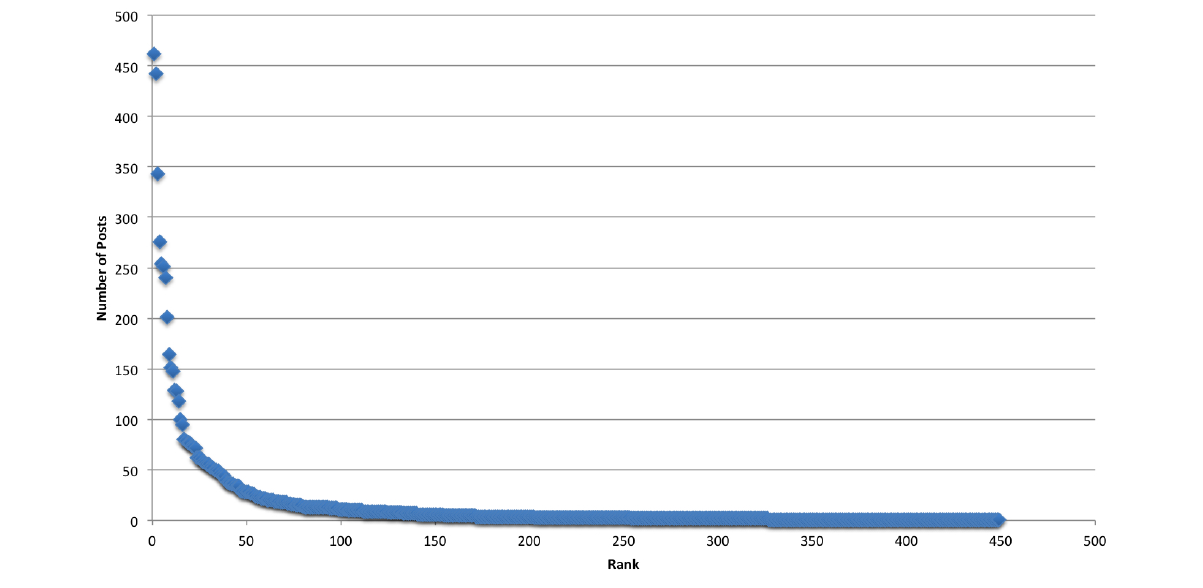
Figure 3. Cumulative posting trends in Alcohol Help Center.